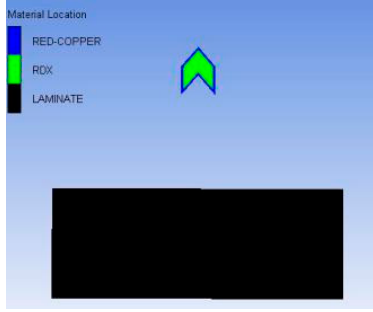
Figure 9. Numerical model diagram.